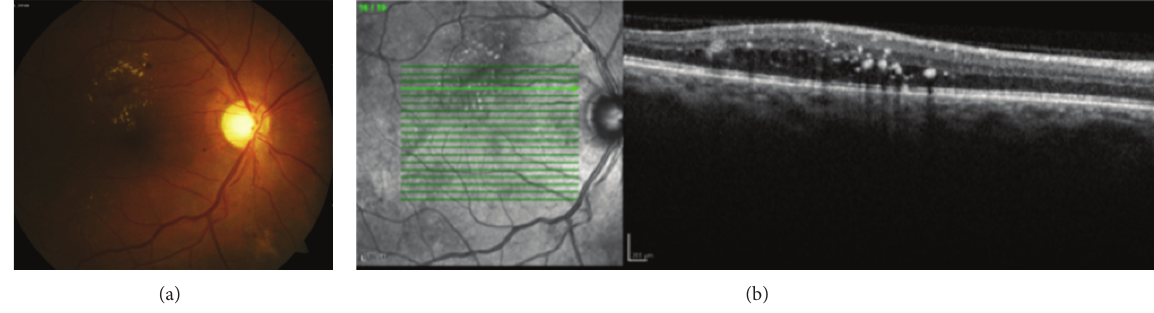
Figure 2: (a) Fundus photograph of the right eye of a patient with diabetic retinopathy with hard exudates and focal edema temporal superior to the macula. (b) Optical coherence tomography of the patient showing intraretinal edema and hard exudates.